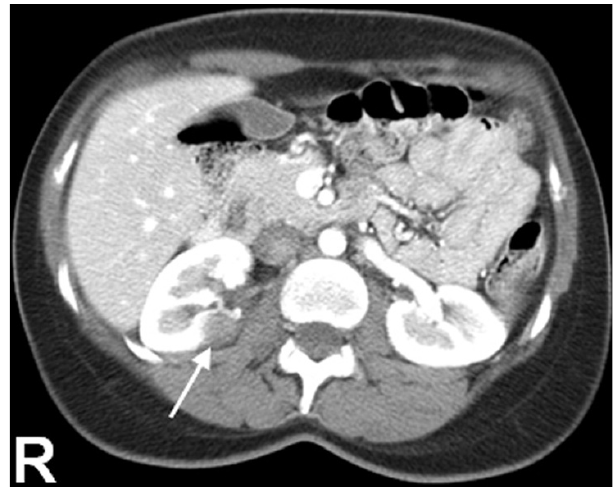
Figure 1 Contrast computed tomography scan of abdomen demon- strating right renal mass with calcifications (arrow). R indi- cates right